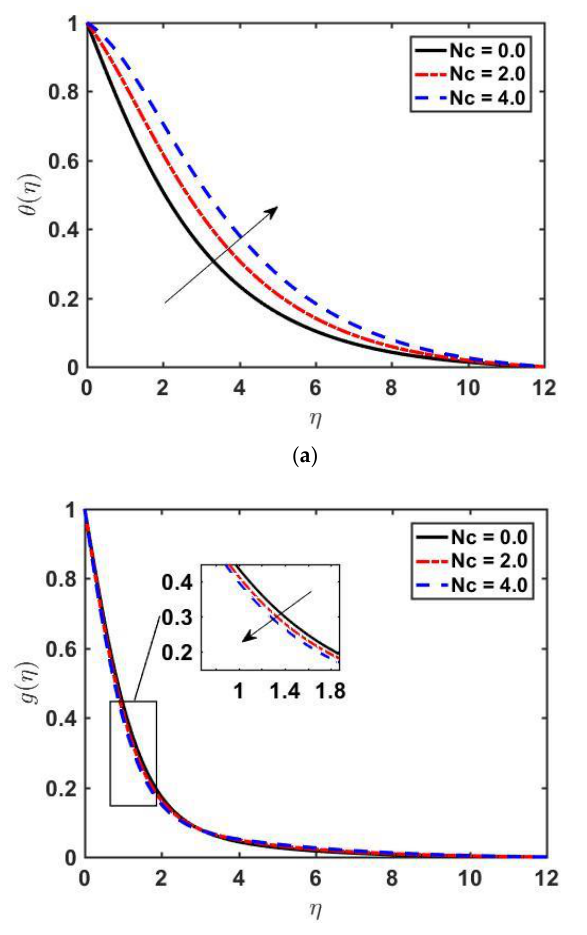
Figure 7. Profiles of 𝜃(𝜂) and 𝑔(𝜂) versus η for various values of 𝑁𝑐 by fixing 𝜆 = 0.3, 𝑀 = 0.5, 𝑃𝑟 = 0.5, 𝐿𝑒 = 3.0, 𝑁𝑏𝑡 = 2.0, and 𝑆𝑐 = 2.0.